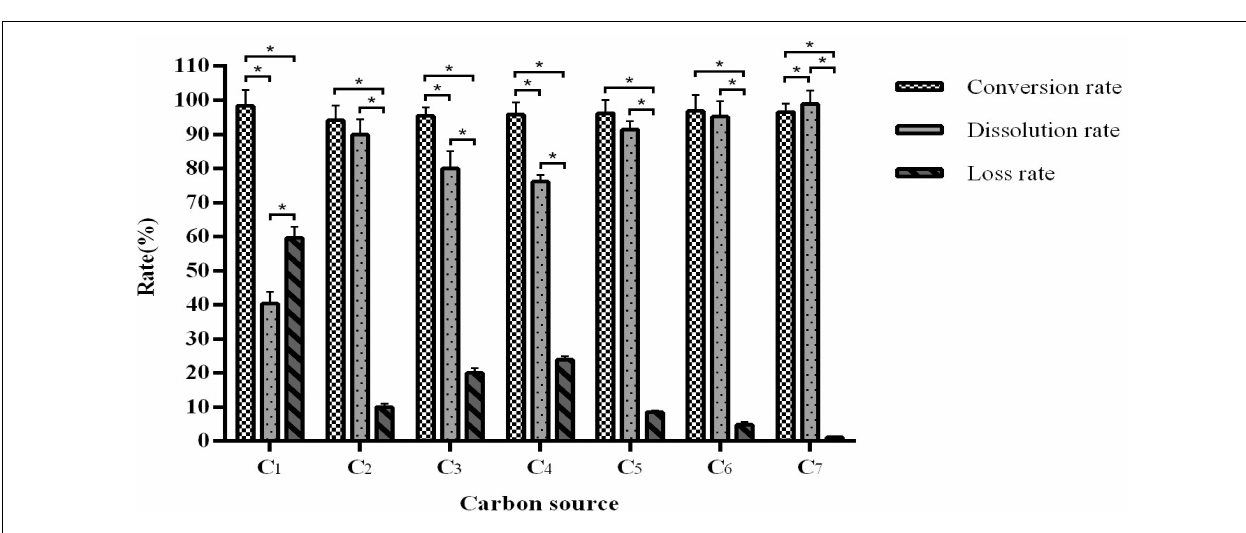
FIGURE 1 | Comparison of the single and mixed strain fermentation capabilities. *Indicates significance at the 0.01 level.